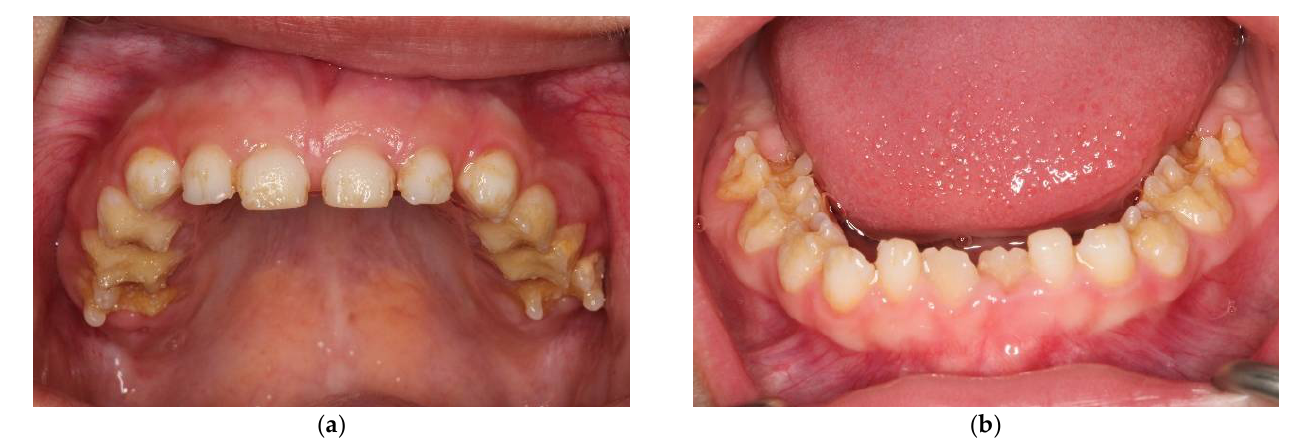
Figure 1. A 5 ½-year-old patient with AI type I: ( a ) upper teeth; ( b ) lower teeth. Clinical exanimation revealed pain and hypersensitivity in yellow teeth and loss of dental structure (pits).